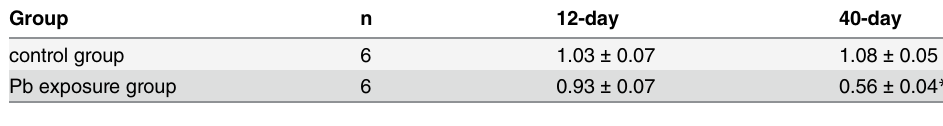
Table 2. The ratio of Bcl-2/Bax in cardiac tissue in two groups.